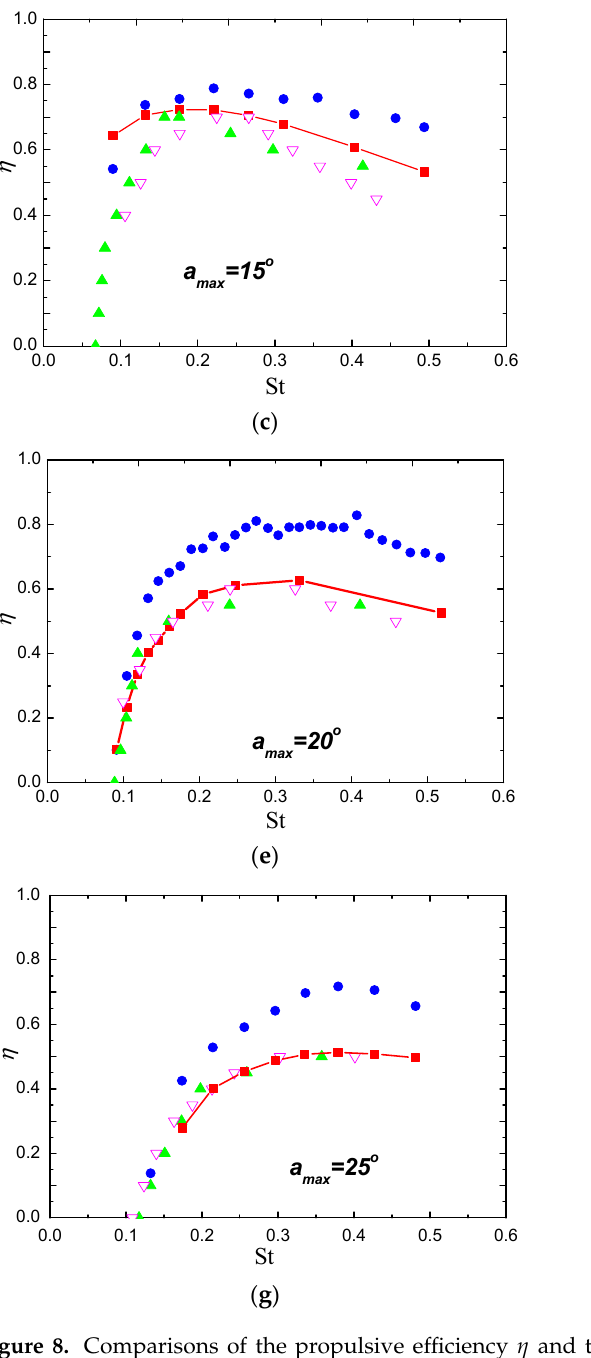
St = 0.176 η = 72.36% α max = 20° St = 0.33 η = 62.73% Figure 9. Vorticity filed at some higher efficiency conditions. ( a ) Experiments result of Schouveiler et al. 2005 ( b ) Numerical results in the current work. Figure 10. Vorticity pattern visualized in the foil wake, for St = 0.45, a max = 20°.